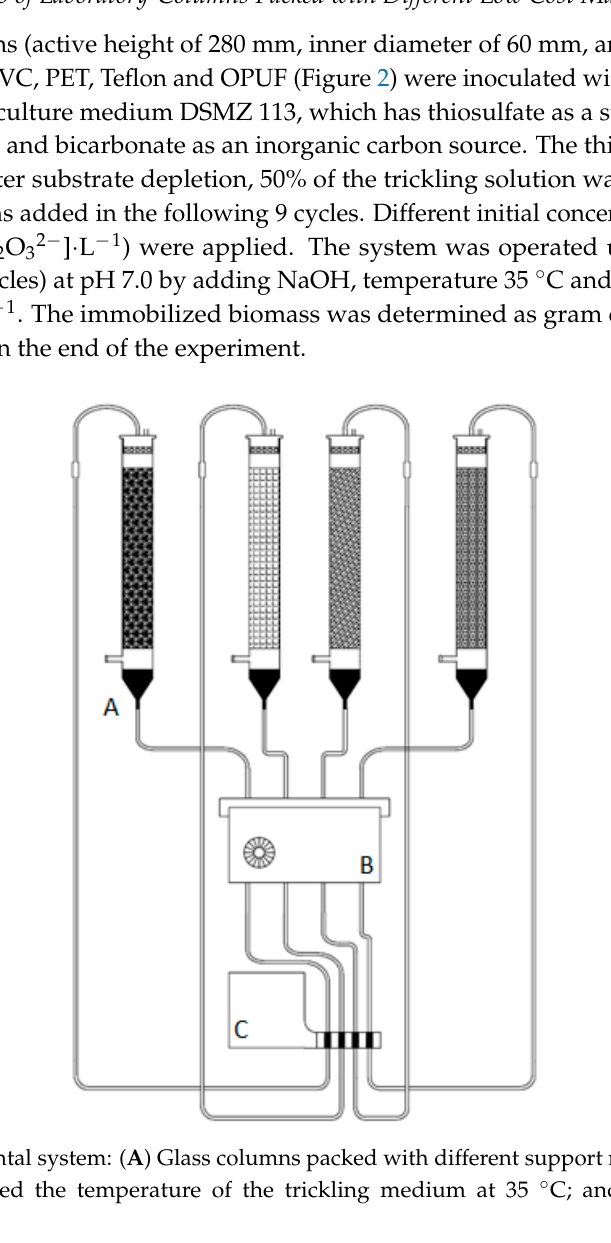
Figure 1. Packing materials: ( a ) PVC; ( b ) PET; ( c ) Teflon®; ( d ) OPUF.